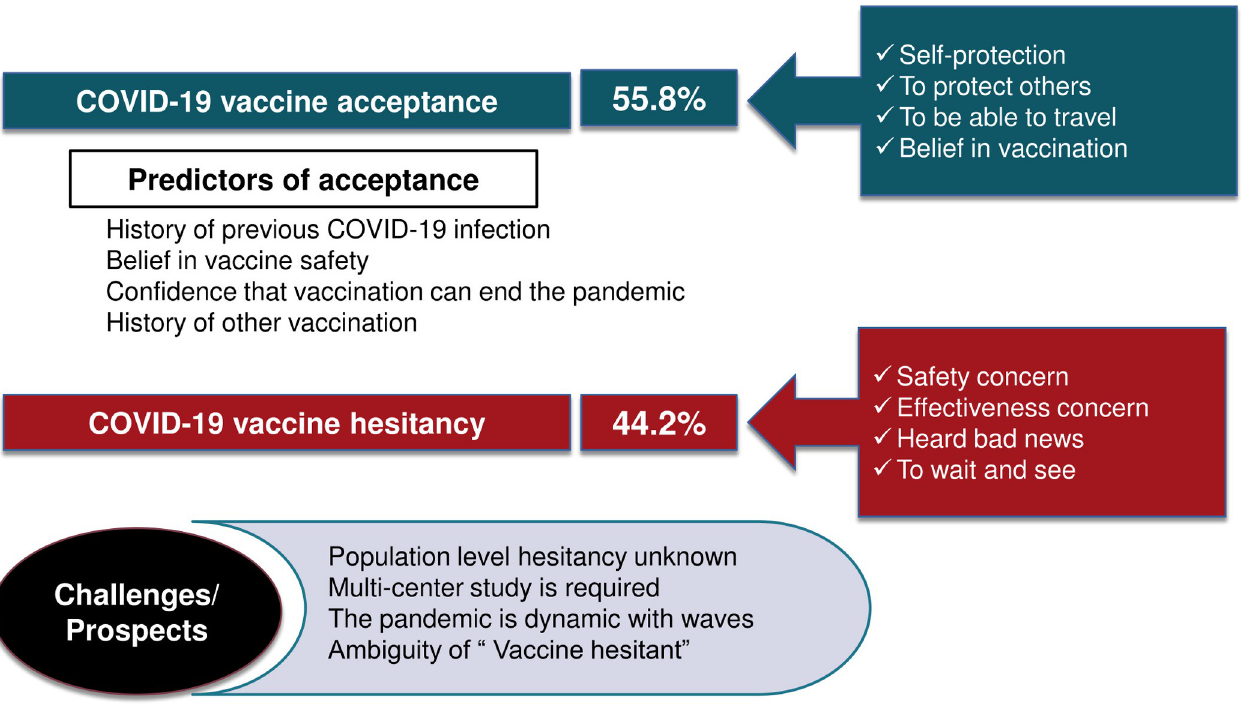
Fig 2. Summary, challenges, or prospect of the present